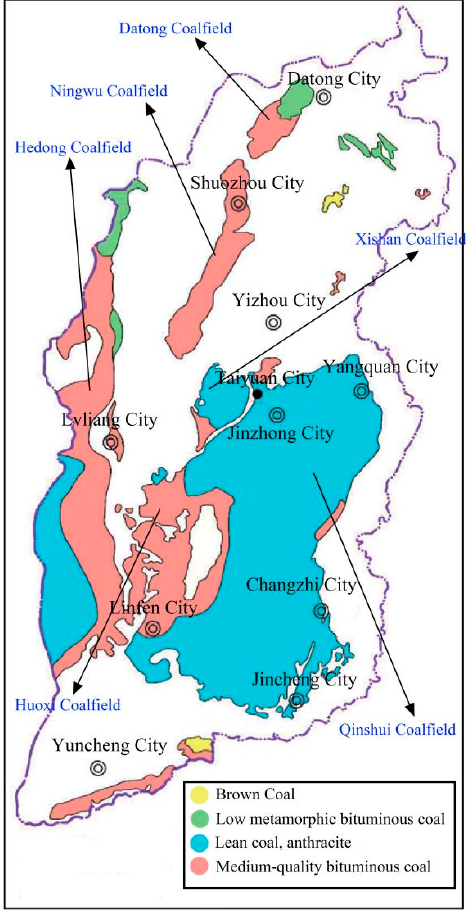
Figure 3. Distribution of coal fields and coal types in Shanxi Province.